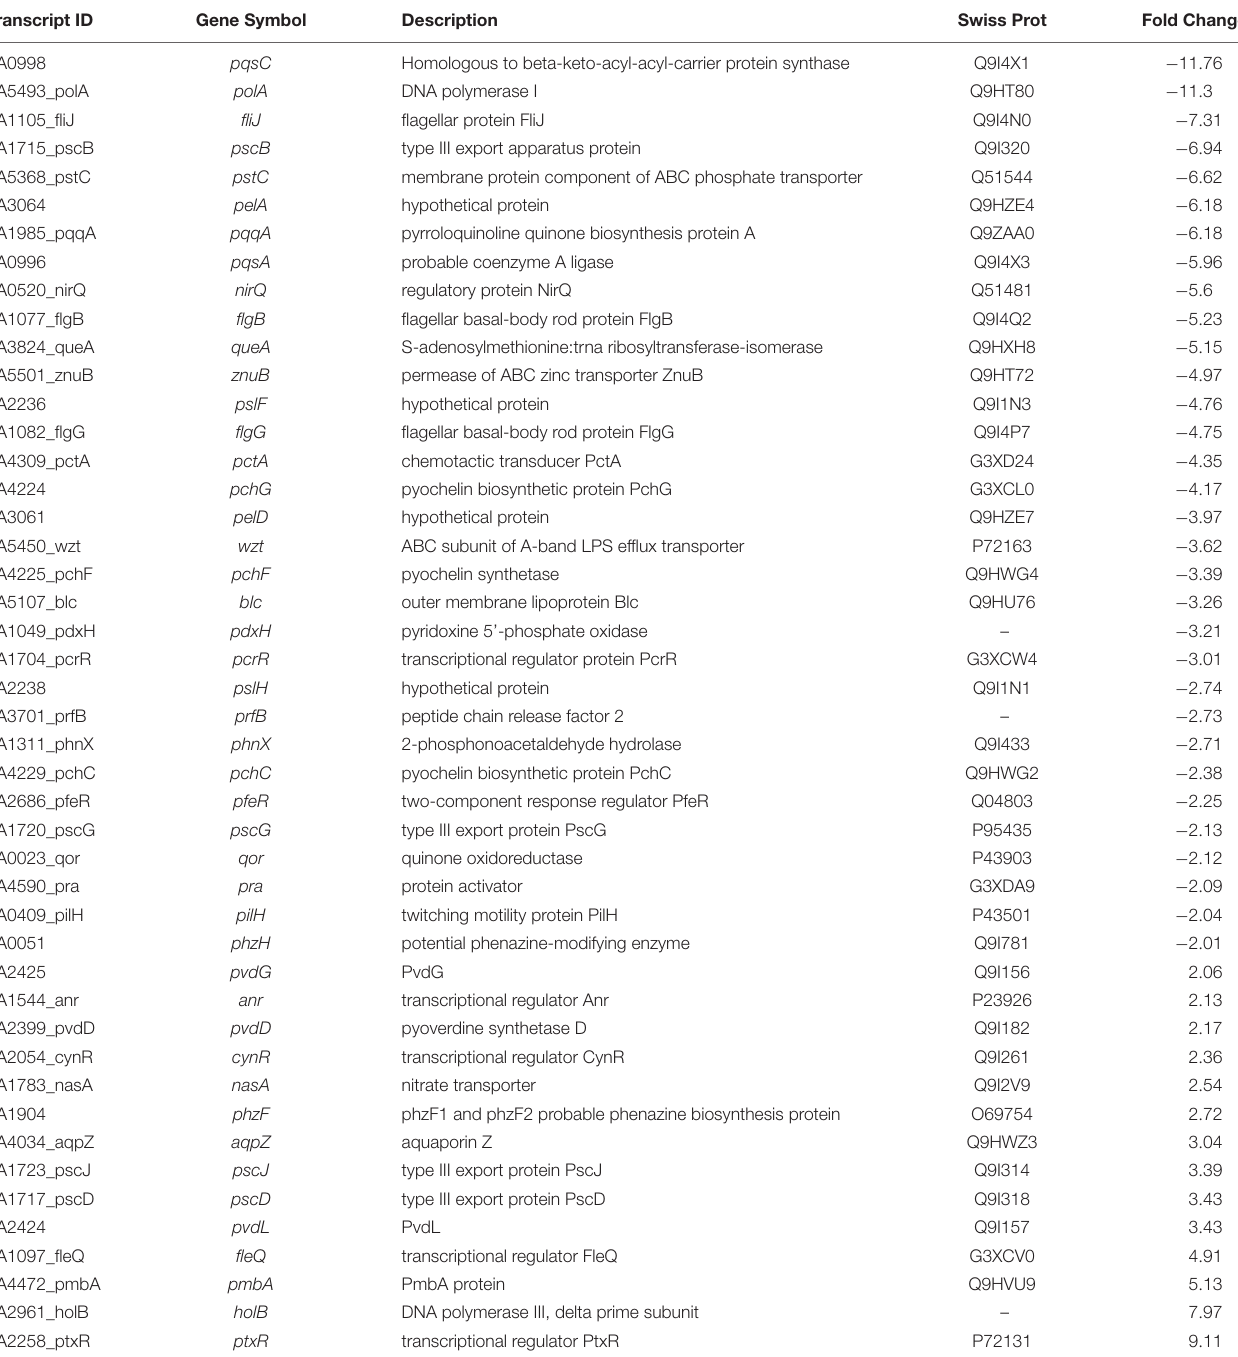
TABLE 1 | Selected transcripts that are differentially expressed (up- or down- regulated) in P. aeruginosa PAO1, treated with the bacterial ( E. indicum SJ16) active fraction compared to control (untreated PAO1 strain). Transcript ID Gene